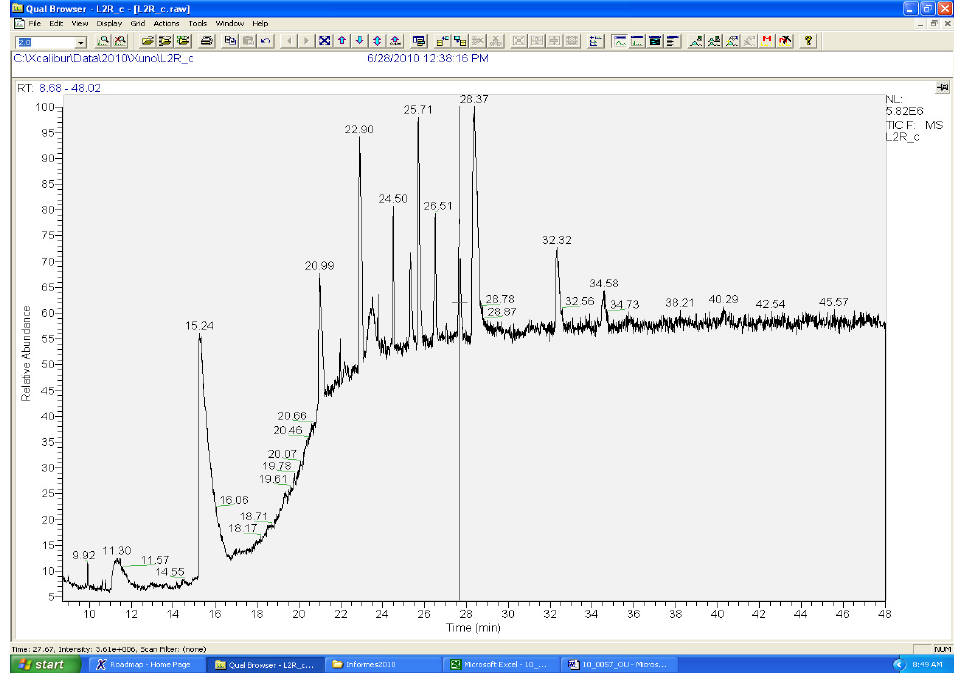
Figure 1. Sample of cromatogram of macroalgae